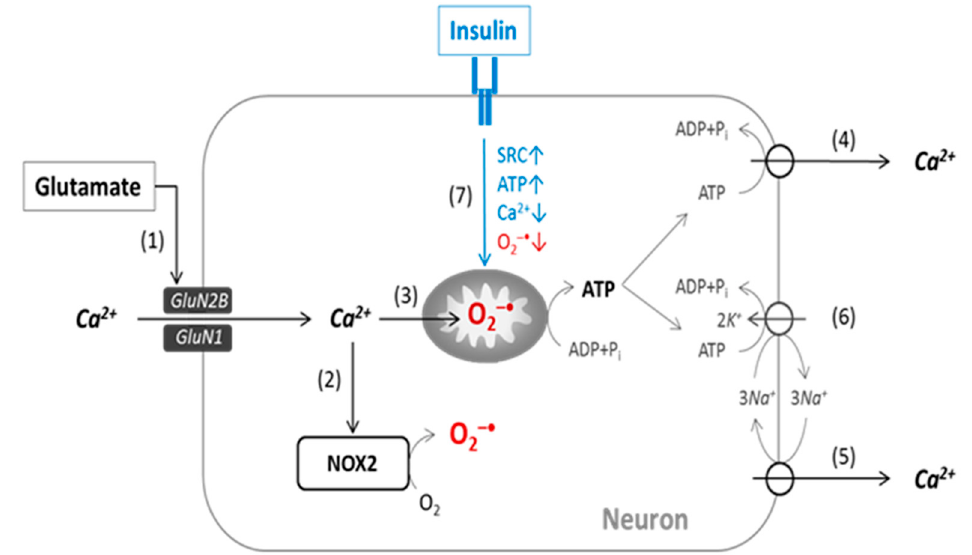
Figure 5. Scheme for a functional relationship between NMDAR and the insulin receptor (IR) during superoxide generation in excitotoxicity. After glutamate-evoked NMDAR activation (1), Ca 2+ entry leads to an increase in superoxide [O 2 − • ] generation at NOX2 (2) and a rise in superoxide in the mitochondrial matrix (3). The NMDAR-gated Ca 2+ influx is counterbalanced by ATP-dependent Ca 2+ efflux mediated by plasma membrane Ca 2+ -ATPase (4) and the Na + /Ca 2+ -exchanger (NCX), (5) coupled with Na + /K + -ATPase (6). Following Ca 2+ entry into the mitochondrial matrix, ATP depletion occurs, thus affecting the ATP-dependent efflux of Ca 2+ and leading to a rise in [Ca 2+ ] i . Insulin significantly increases spare respiratory capacity SRC (7), thus maintaining ATP production and improving ATP-dependent Ca 2+ efflux. This prevents [Ca 2+ ] i from rising, which in turn reduces superoxide generation in NOX2 and in